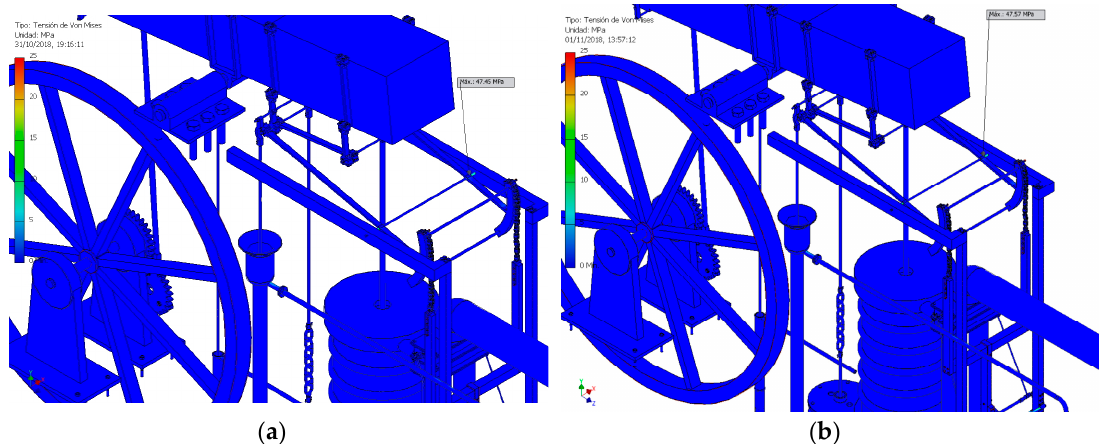
Figure 16. Location of the second highest von Mises stress: ( a ) downward movement and ( b ) upward movement.